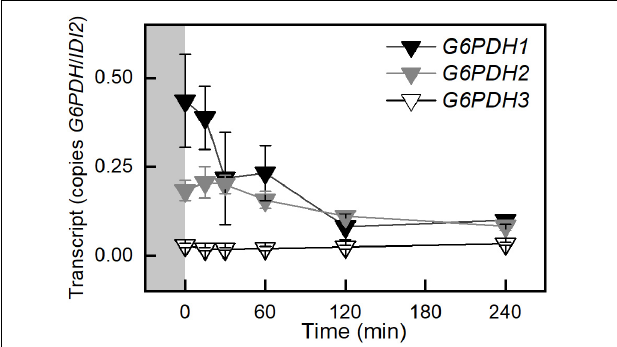
FIGURE 5 | Changes in transcription of the plastid G6PDH s in Col-0 in response to an increase in PFD from 120 to 500 µ mol m − 2 s − 1 C a 400 ppm. Gray block indicates sampling in growth conditions, PFD 120 µ mol m − 2 s − 1 and 400 ppm CO 2 . n =